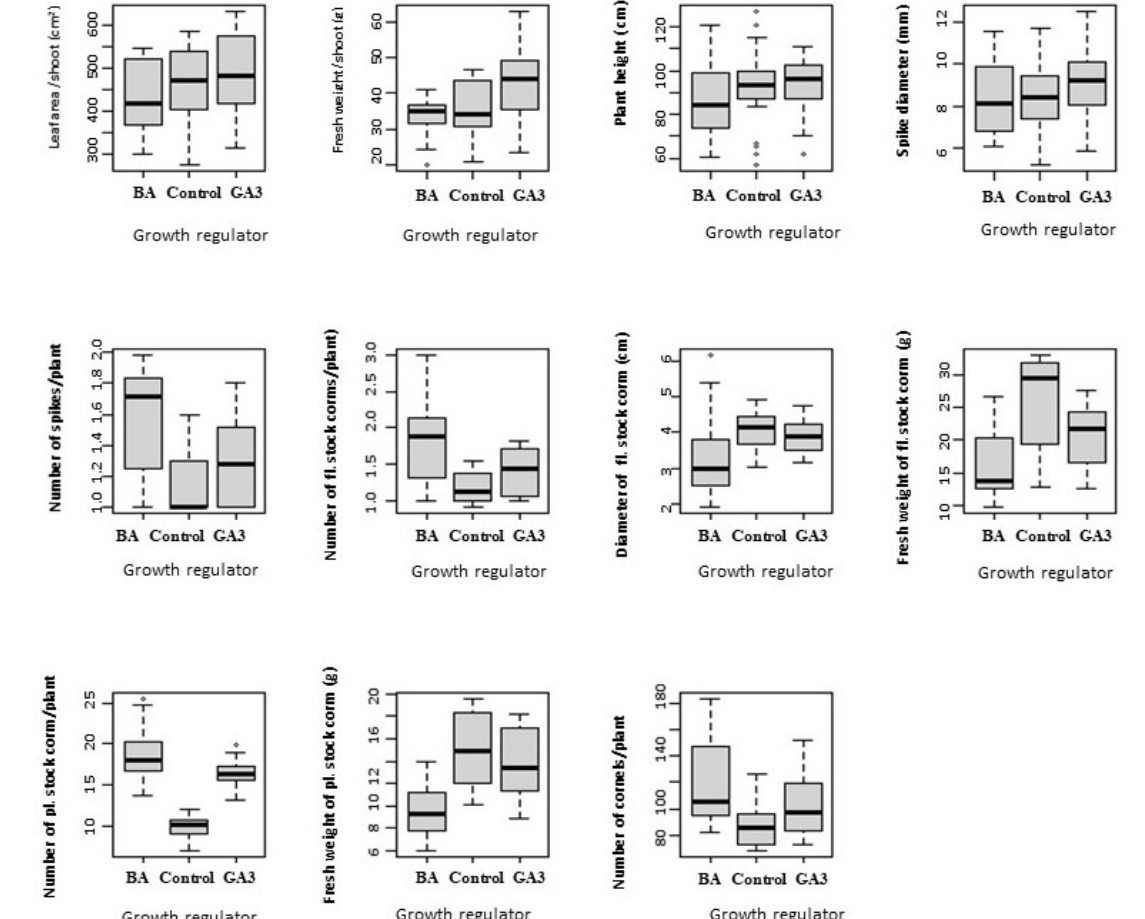
Figure 2. The effect of variety on the different corm and leaf variables illustrated as boxplots where a box defines a lower and an upper percentile, in which 75% of the observations are found, and the marked line defines the median value of a given